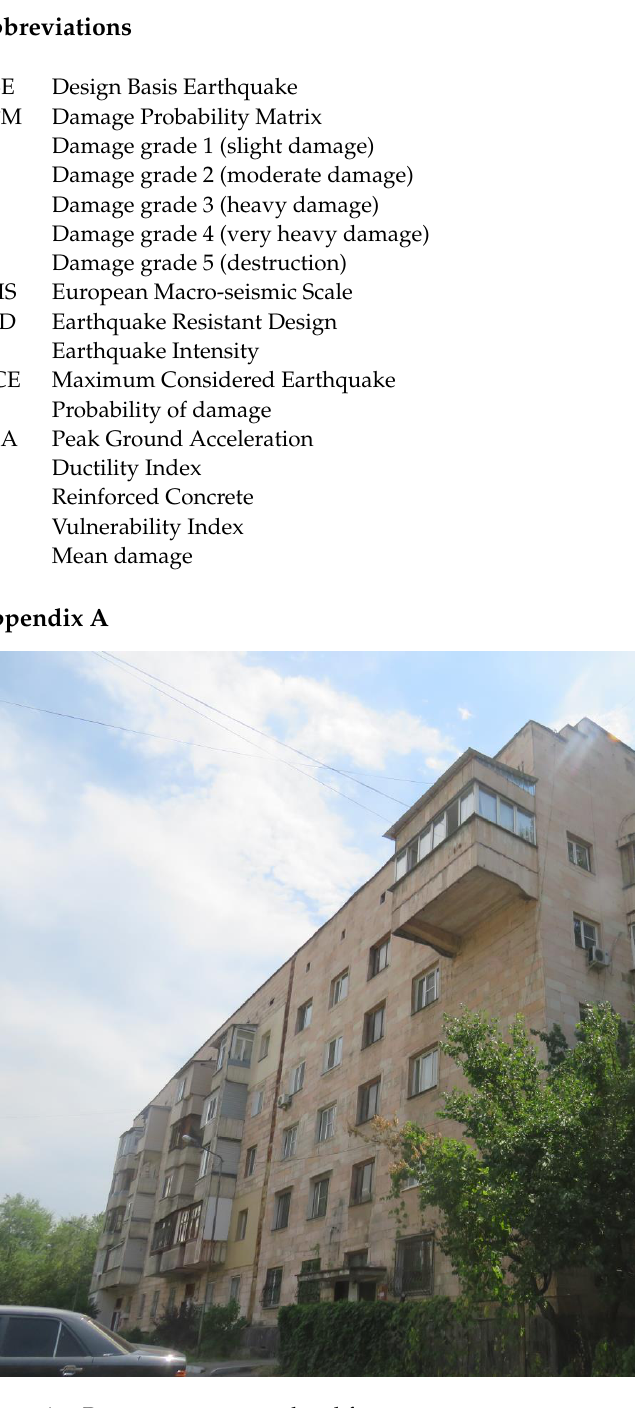
Figure A1. Precast concrete emulated frame.